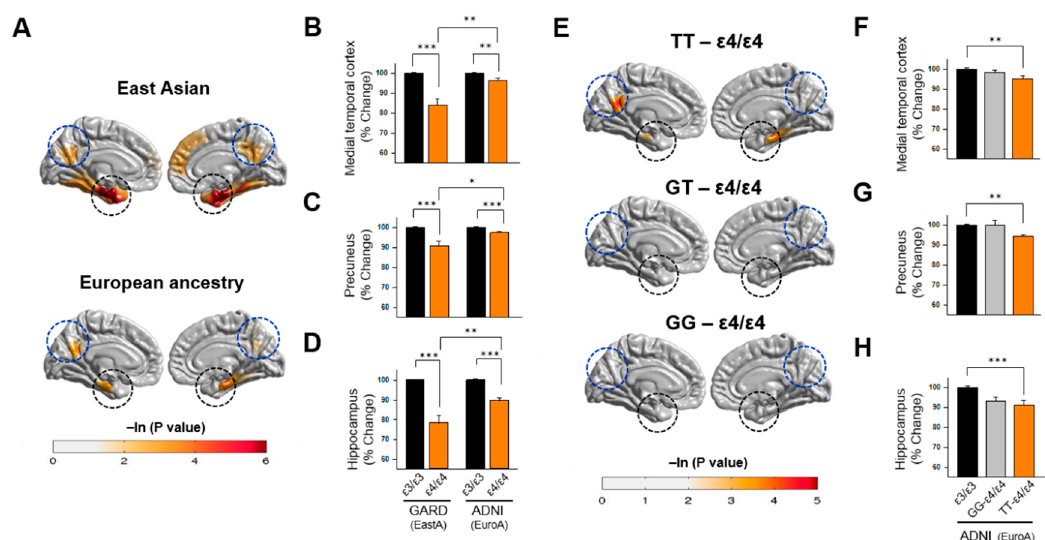
Figure 3. APOE ε 4 / ε 4-sensitive brain atrophy is greater in East Asians (EastA) compared to individuals of European ancestry (EuroA). ( A ) Cortical thinning maps in EastAs and EuroAs. A general linear model was applied to infer the point-wise cortical thickness di ff erences using APOE genotype ( ε 4 / ε 4 vs. ε 3 / ε 3) as a predictor adjusted for age, sex, and field strength covariates. Statistically greater thinning in ε 4 / ε 4 compared to ε 3 / ε 3 individuals is shown for the entorhinal and parahippocampal regions (encompassed in dotted black circles) and precuneus region (encompassed in blue circles). Average cortical thickness in the medial temporal cortex (entorhinal and parahippocampal regions ( B )), precuneus ( C ), and hippocampus ( D ) was compared between APOE genotypes ε 4 / ε 4 and ε 3 / ε 3 in EastA and EuroA individuals. Data were normalized to ε 3 / ε 3 and shown as percentages with error bars indicated above the bar plot (* p < 0.05, ** p < 0.01, *** p < 0.001). ( E ) Cortical thinning in EuroAs comparing individuals with combinations of rs405509- ε 4 / ε 4 genotypes with the ε 3 / ε 3 genotype using a general linear model and showing regional di ff erences as described in Panel A. Average cortical thickness in the medial temporal cortex (entorhinal and parahippocampal regions, ( F )), precuneus ( G ), and hippocampus ( H ) was compared between ε 3 / ε 3 and either rs405509 (TT)- ε 4 / ε 4 or rs405509 (GG)- ε 4 / ε 4 individuals. Data were normalized to ε 3 / ε 3 and shown as a percentage with error bars indicated above the bar plot (* p < 0.05, ** p < 0.01, *** p < 0.001). Abbreviations: GARD, Gwangju Alzheimer’s and Related Dementias Study; EastA, East Asian; ADNI, Alzheimer’s Disease Neuroimaging Initiative; EuroA, European ancestry.